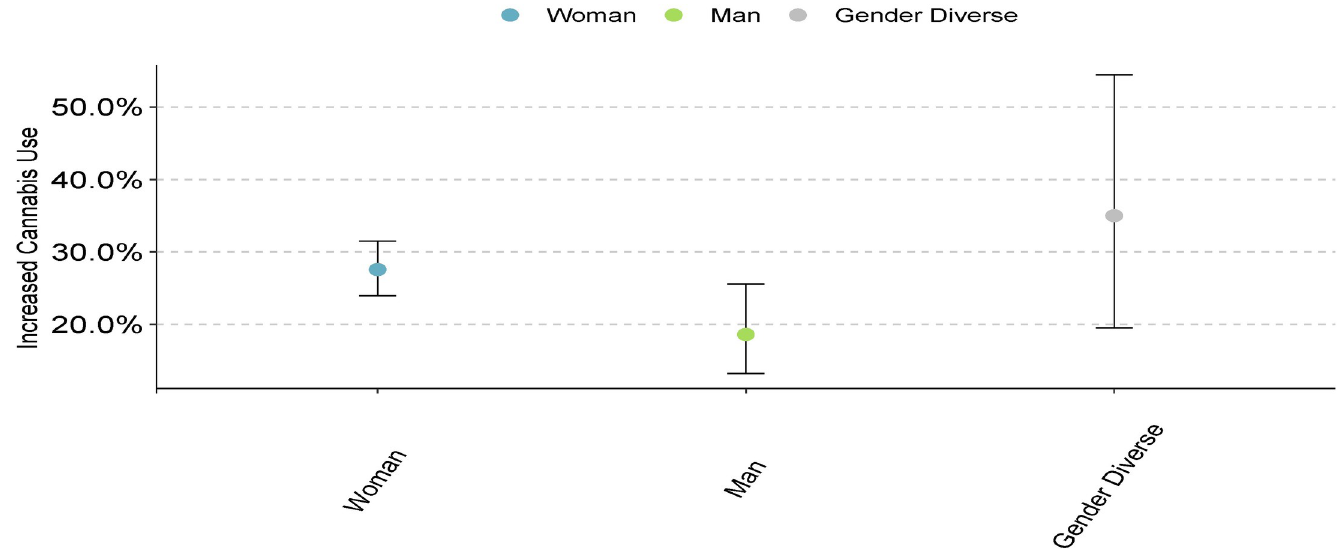
Fig 6. Cannabis use across different